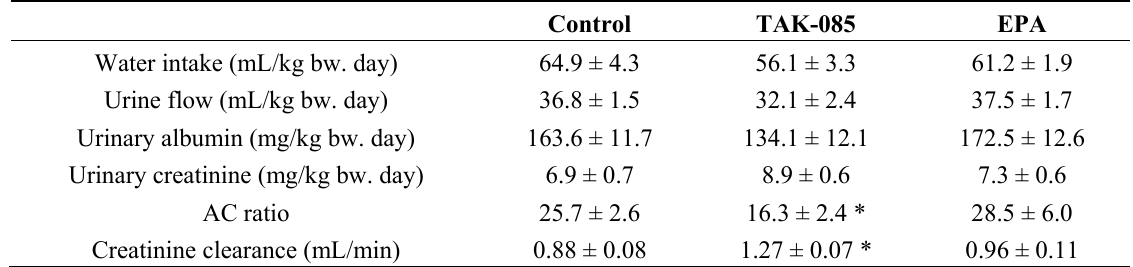
Table 2. Effects of TAK-085 and EPA on renal functions.